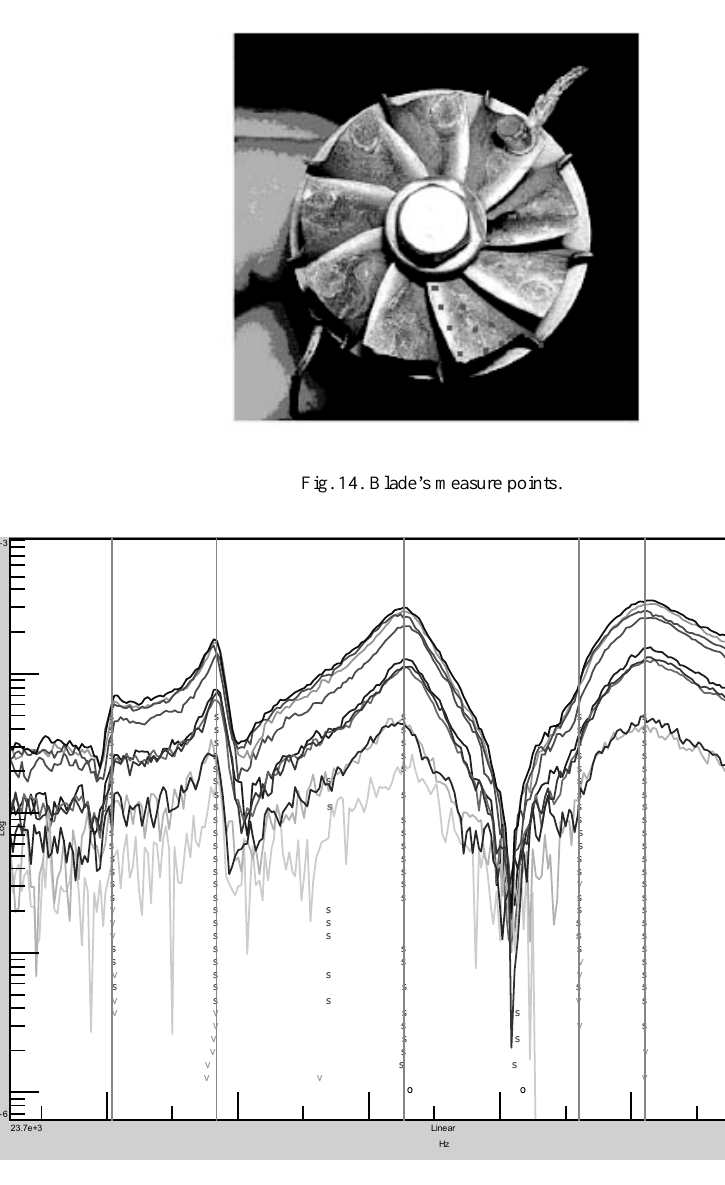
Fig. 15. Stabilisation diagram for the blade mapping